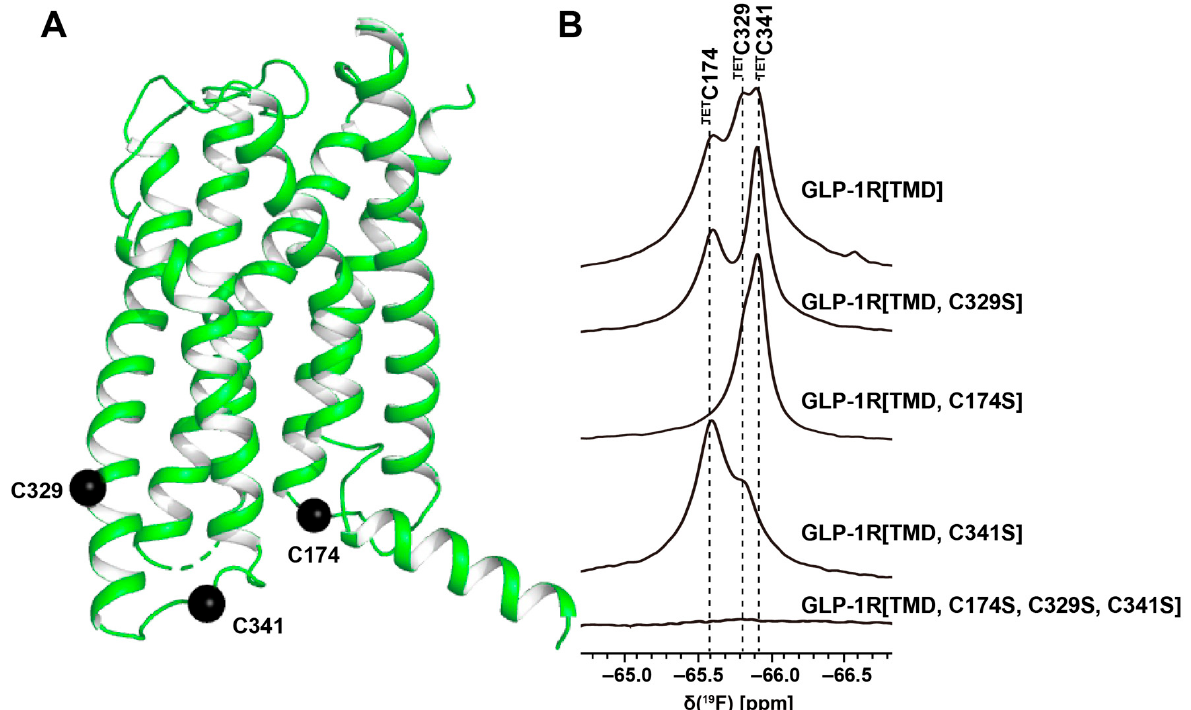
Figure 4. Sequence-specific assignment of the 19 F-NMR signals of TET moieties attached to the three native Cys residues near the intracellular surface of the transmembrane domain (TMD) of the GLP-1R. ( A ) Crystal structure of the GLP-1R[TMD] (PDB: 5VEX; generated using the PyMOL Molecular Graphics System, Schrödinger, LLC, New York, USA) shown as a green cartoon. Three native Cys residues, C174, C329 and C341, shown as black spheres, are exposed on the intracellular surface and are thus accessible for TET labeling with the IMCM method [56]. ( B ) 1D 19 F-NMR spectra. The GLP-1R[TMD] spectrum contains three signals corresponding to the three Cys sites shown in ( A ). Individual assignments of the 19 F-NMR signals were obtained using site-specific mutagenesis to replace cysteines with serine residues. The peak assignments indicated at the top by the one-letter amino acid code and the residue number are based on the disappearance of the signals of the replaced cysteines. (Adapted from Figure 1 in reference [57]).